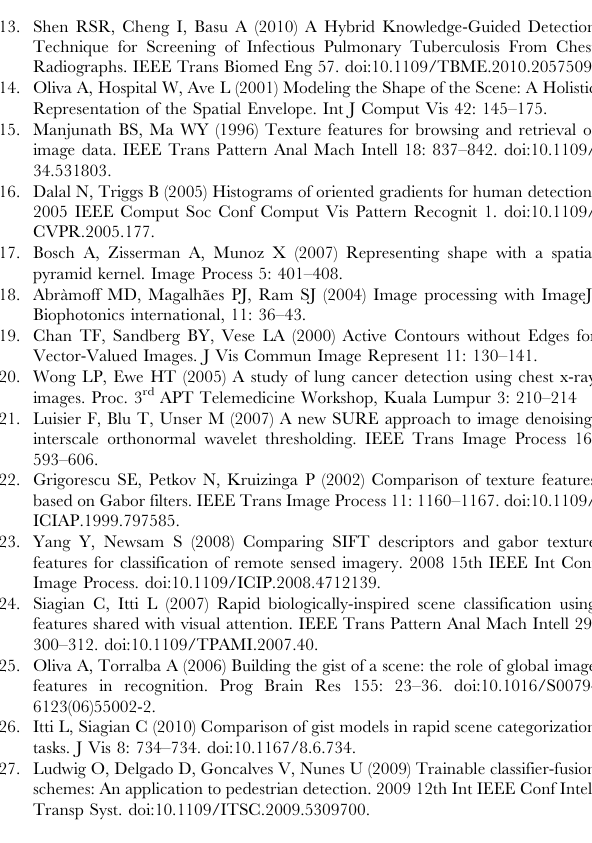
Table S1 Various grey-level co-occurrence matrix (GLCM) textural features used for the